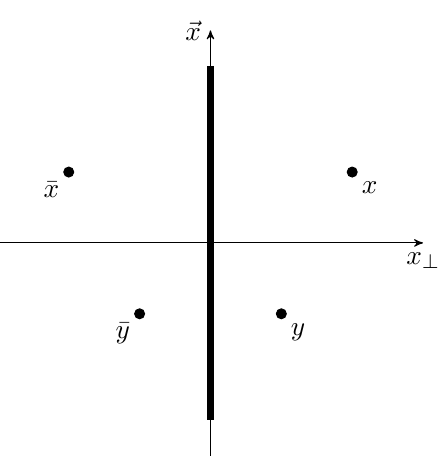
Figure 1 . Coordinates x , y and boundary at x ? = 0. Also pictured are the mirror images (cid:22) x and (cid:22) y